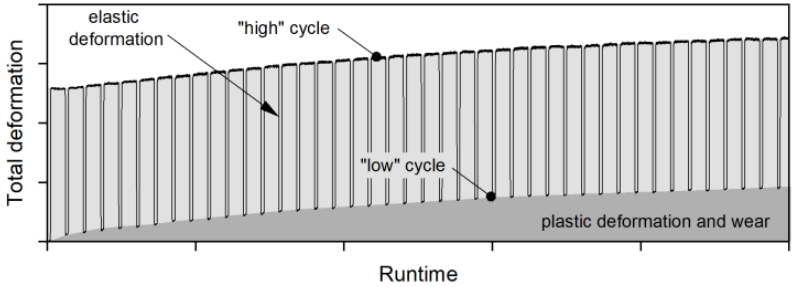
Figure 5. Distinction between elastic deformation and plastic deformation and wear, schematically [37].